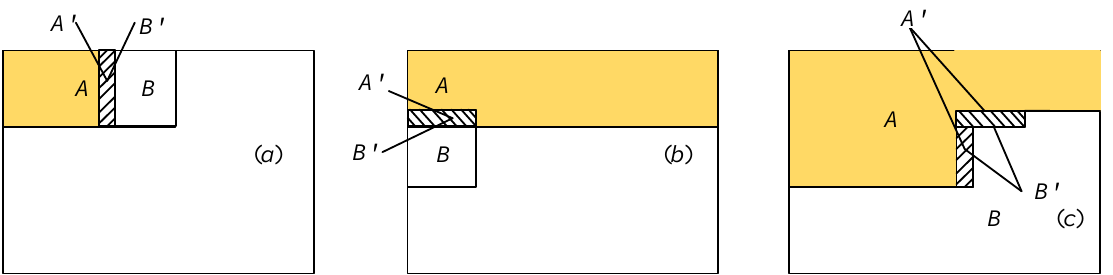
Figure 3. The hatched section shows overlap area. The ( a ) is the synthesis process of the first row. The ( b ) is the synthesis process of the first column, and the ( c ) is in both horizontal and vertical directions in the interior. A is the synthesized area and B is the block to be synthesized, and A ’ and B ’ are the overlaps of block A and B, respectively.